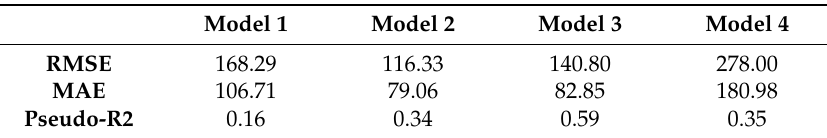
Figure 10. Adjusted R-square in di ff erent training datasets. Table 7. Results of